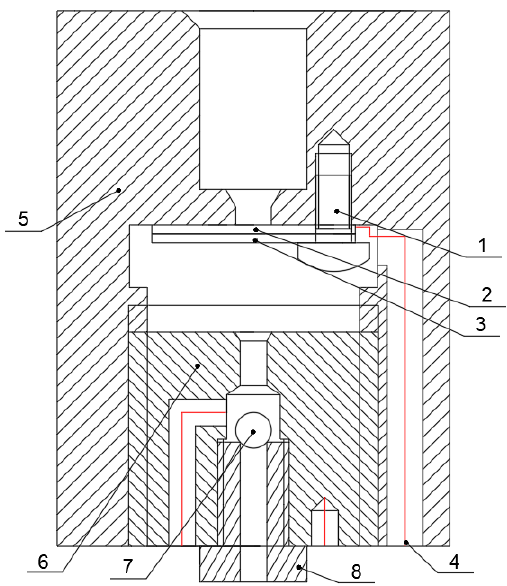
Figure 2. Schematic diagram of the micro oil measuring device.1—rivet; 2—strain gauge; 3—copper sheet; 4—lead; 5—container body; 6—check valve; 7—spool; 8—device support